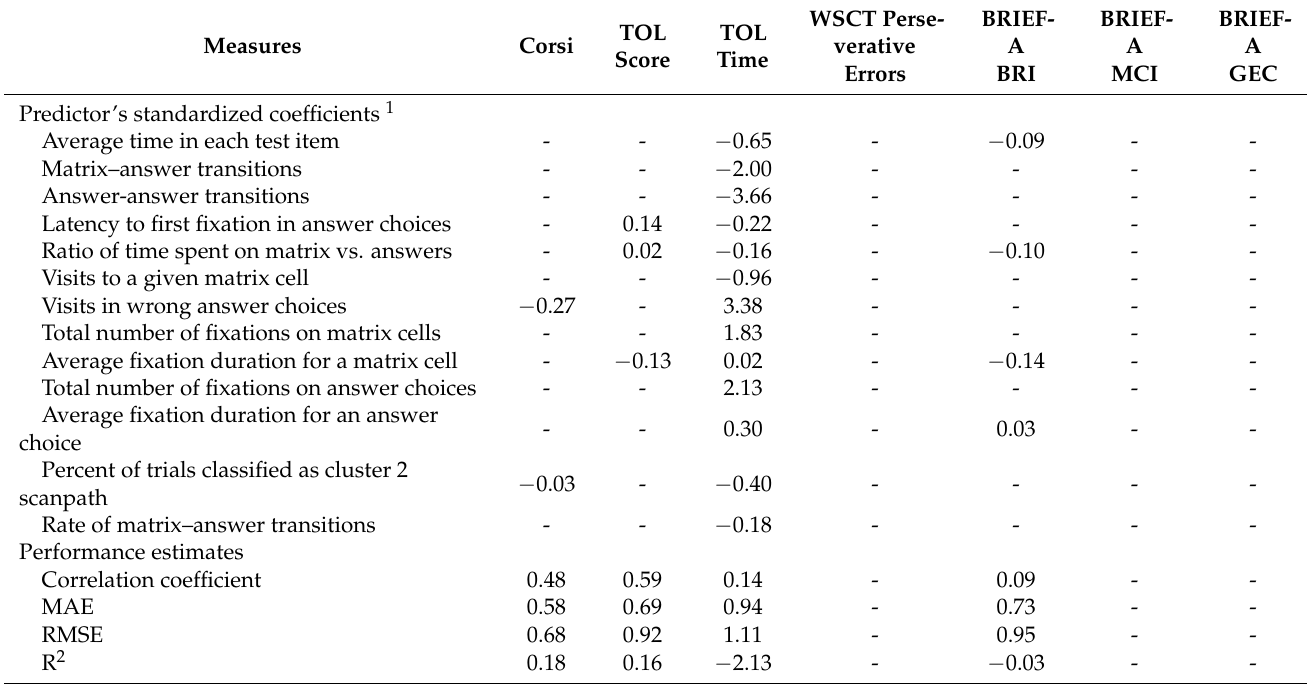
1 Showing the predictors selected by the LASSO model; see full set of eye gaze metrics in Table 1; The R 2 presents the explained variance by the model, while MAE and RMSE represent measures of the error of the model; BRI = behavior regulation Index; MCI = Metacognition Index; GEC = Global Executive